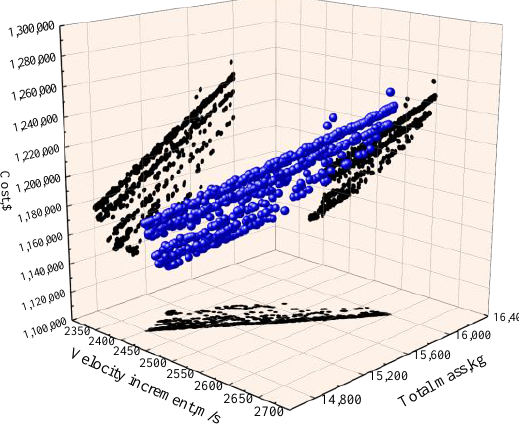
Figure 11. Pareto solution set of HRM-WGPF.